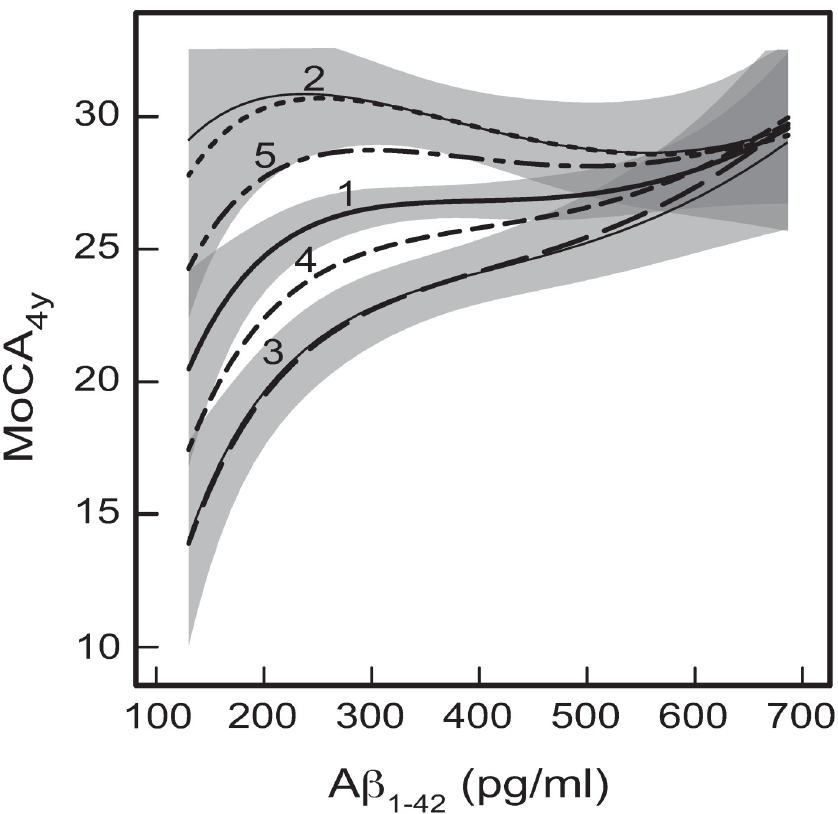
Fig 7. The predicted dependences of MoCA 4y on baseline CSF concentration of A β 1–42 . The dependences result from the GSEM networks given by Fig 1A and 1B (thick curves) and Figs 1A and 2 (thin solid curves) for the following baseline ages: (1) Age = 60 years; (2) Age = 40 years; (3) Age = 80 years; (4) Age = 70 years; and (5) Age = 50 years. The shaded bands show the 95% prediction intervals for the three thick curves 1, 2 and 3. The other variables for these graphs were either taken as their mean/base values: DaT = 1.38, Education = 15.64 years, Gender = Male, GDS = 2.30 for all the curves, and also average (p-tau) -1/2 = 0.283 (p-tau = 12.49 pg/ml) for thick curves 1–5, or were predicted by the effect paths in the developed models (Figs 1A, 1B and